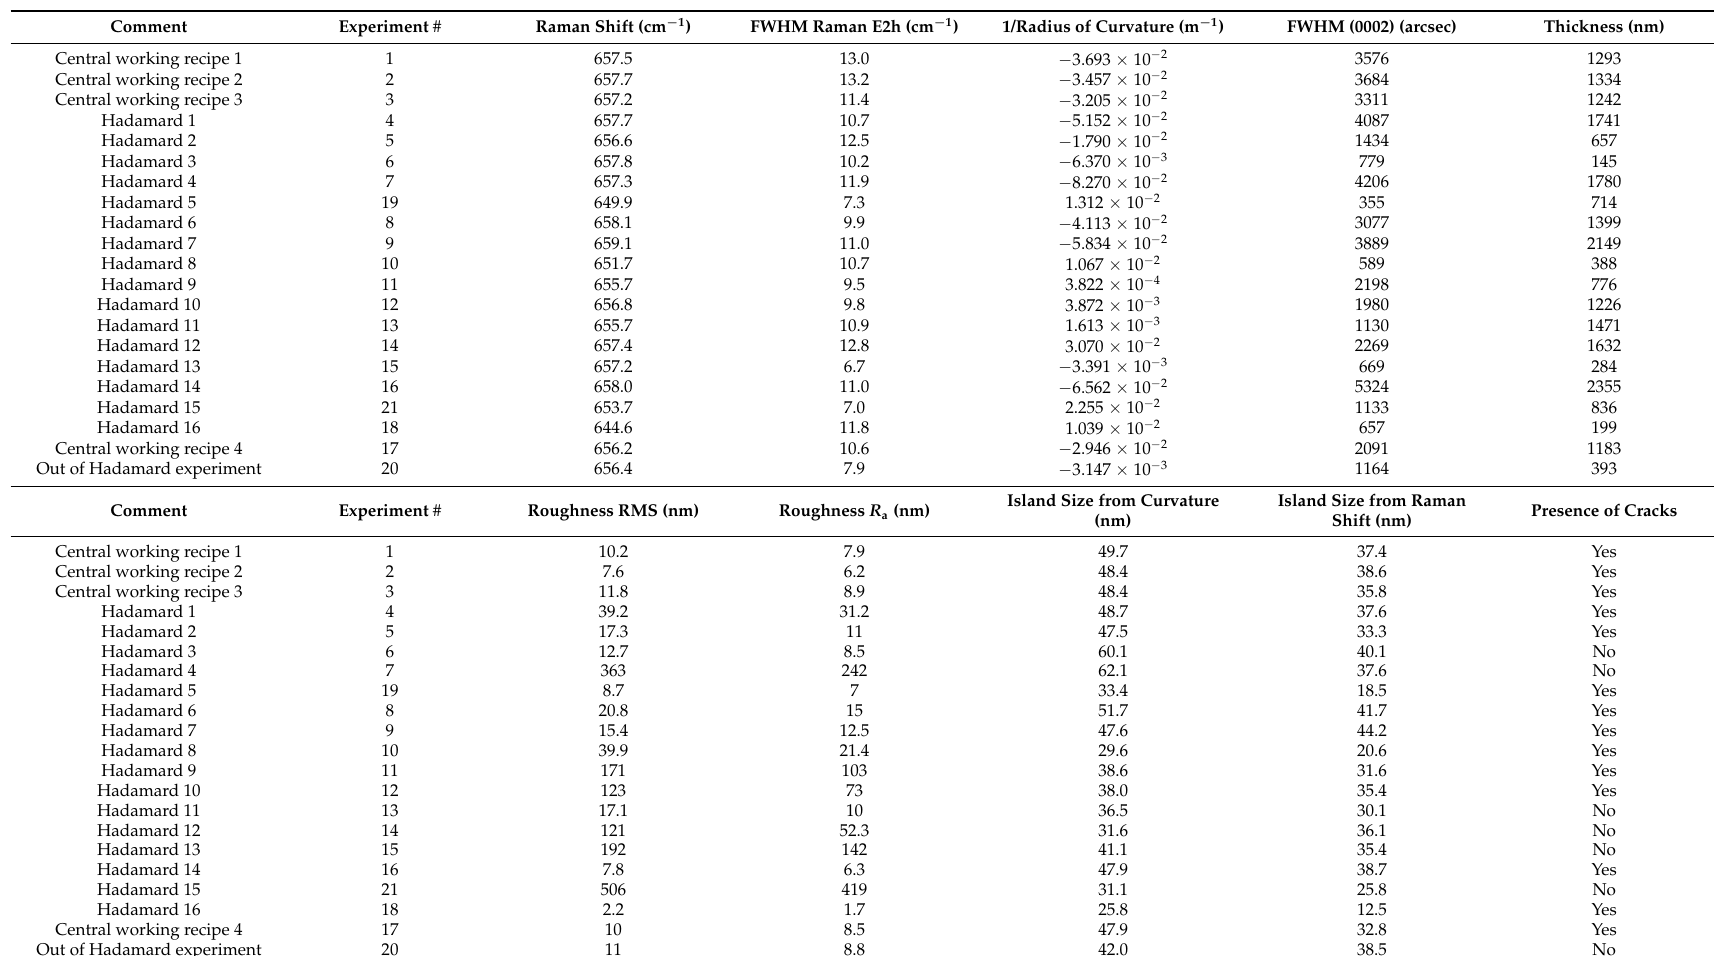
Table 2. Measured outputs of the screening